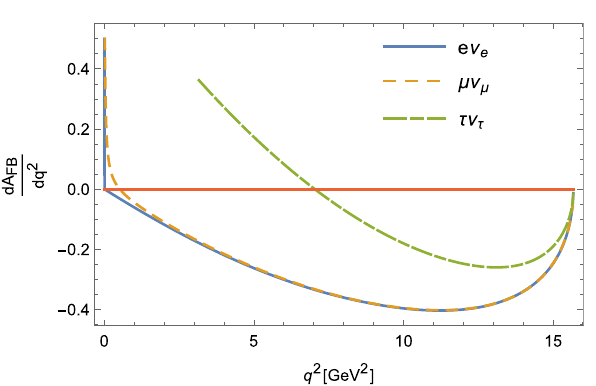
Fig. 5 The FBAs of lepton as functions of q 2 for the decays ¯ B 0 → ( 1320 ) l − ¯ ν ( l = e a + l 2